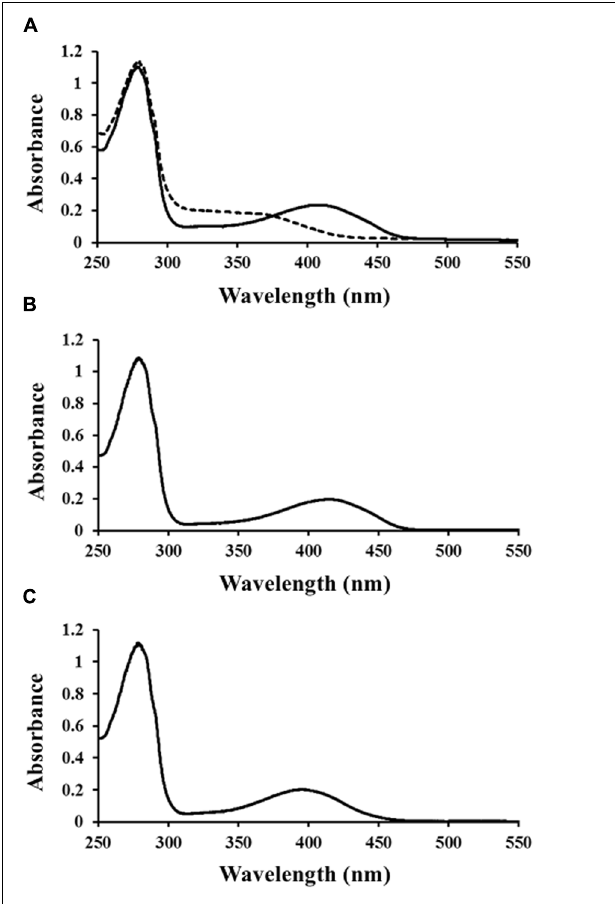
FIGURE 3 | Spectral characteristics of WT (A) , Y123A (B) , and K233A (C) Ls -MalY. UV-vis spectrum of Ls -MalY. Solid and dashed lines indicate